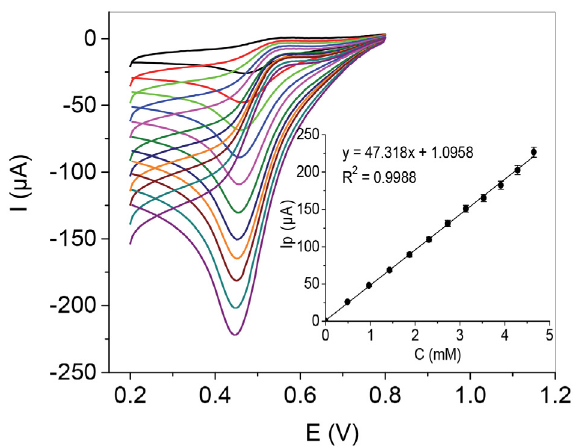
Fig. 3. Voltammetric response of RuOHCF/GC in PBS (pH 1.0) containing different concentration of iodate; scan rate of 100 mV s –1 ; Inset : plot of catalytic peak current vs. iodate